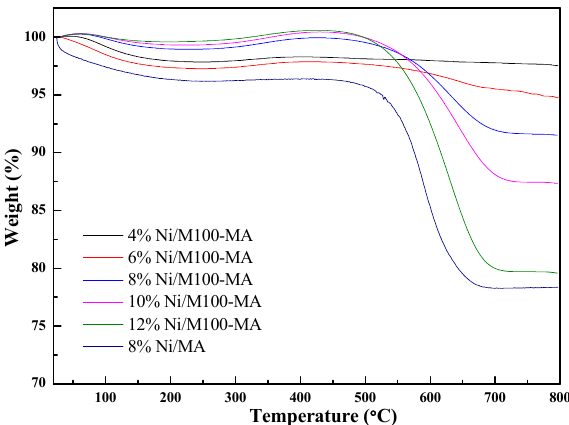
Figure 9. TG profiles of the spent catalysts.